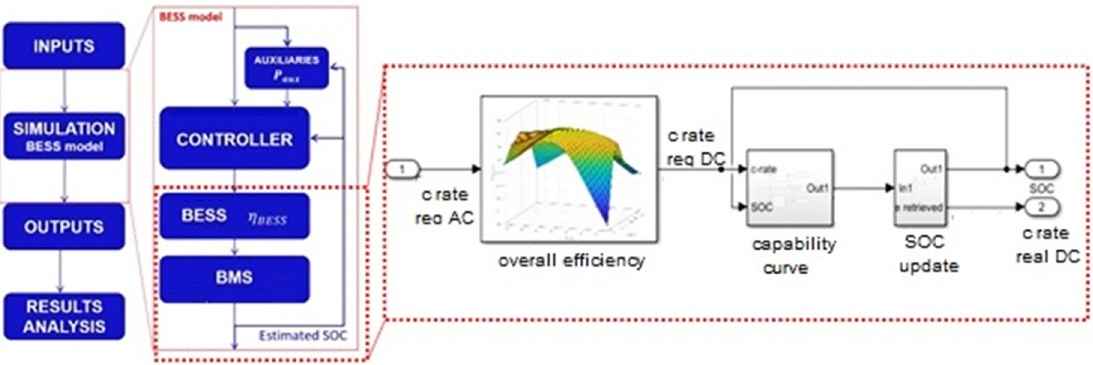
Figure 5. Simulation process flowchart and Simulink BESS + battery management system (BMS)